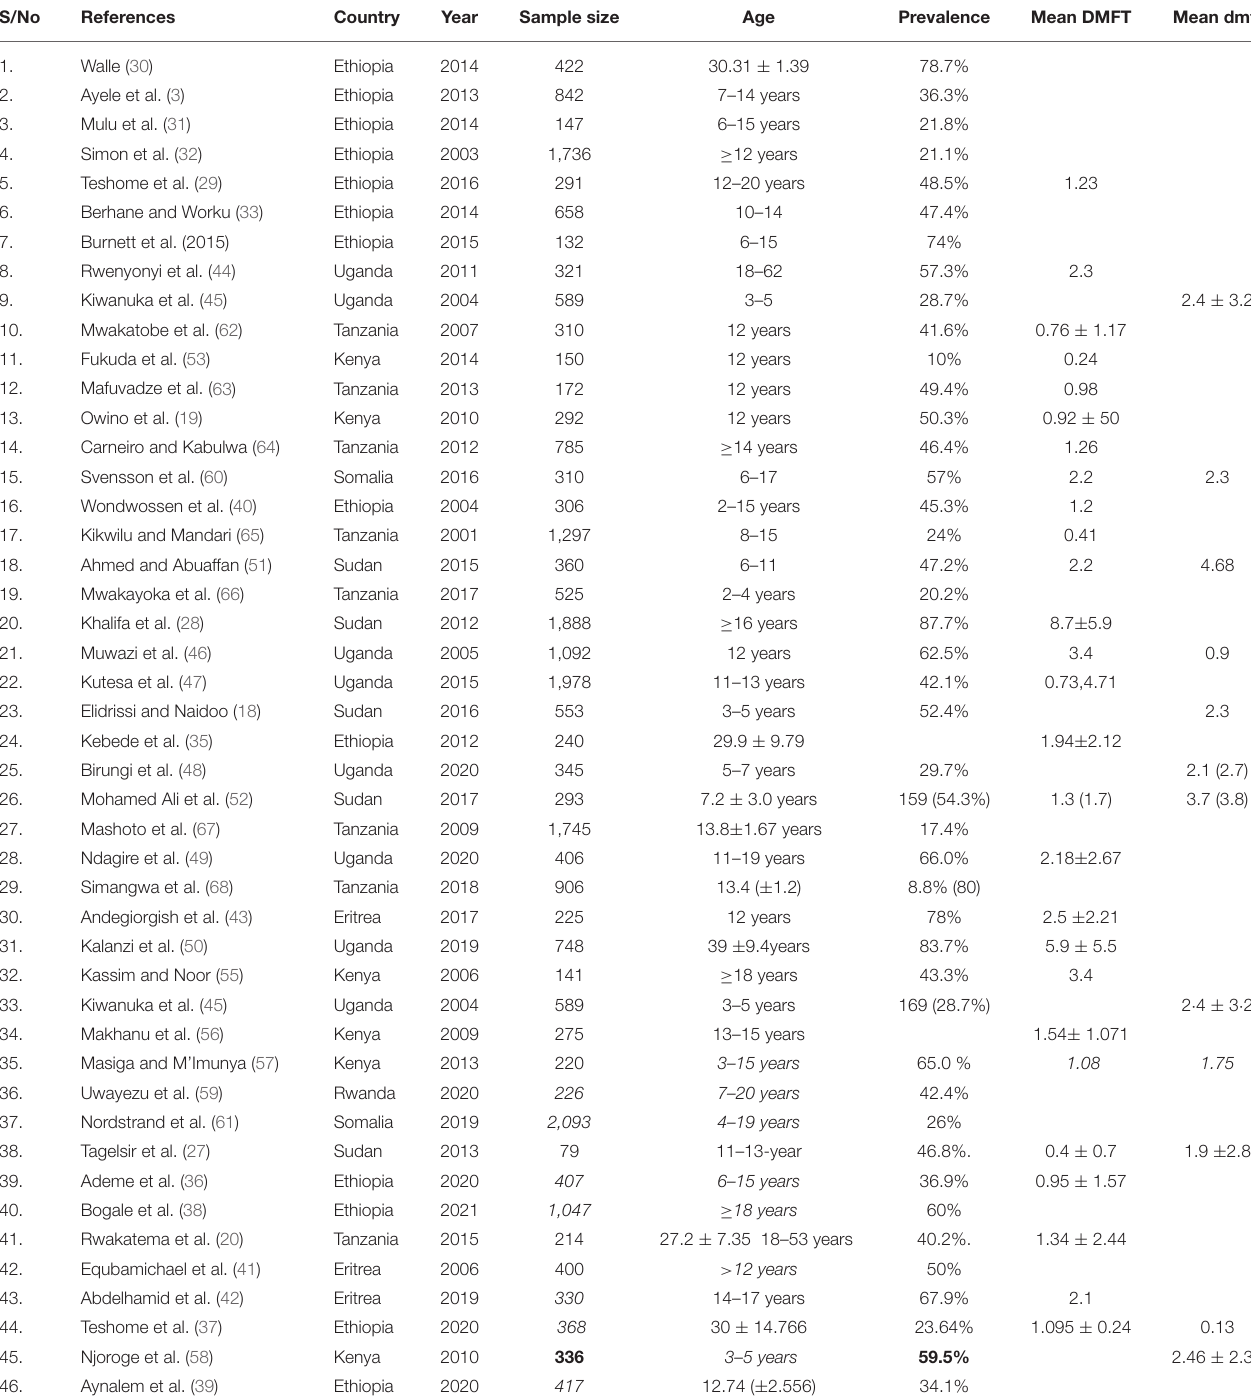
TABLE 1 | Study characteristics of the selected